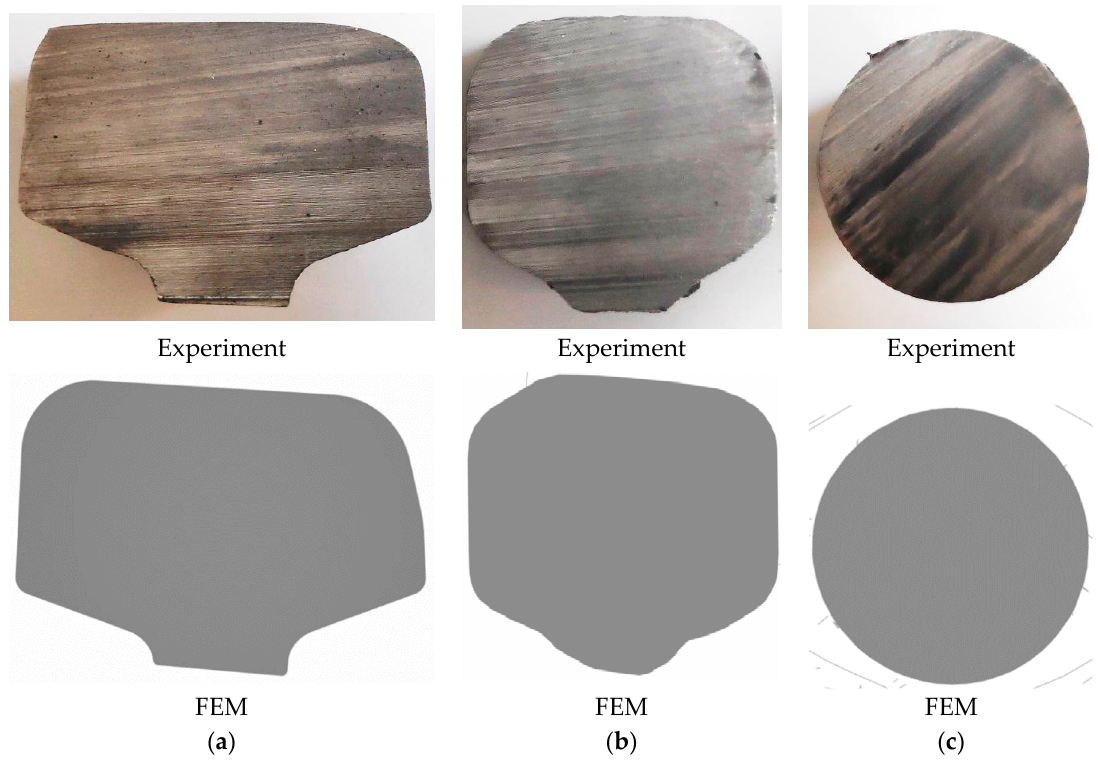
( b ) Figure 15. Changes in the shape of the workpiece during skew rolling of preforms obtained from scrap rail heads: ( a ) determined using FEM; ( b ) determined experimentally. A comparison of the cross-sections of the semifinished products obtained in the numerical simulation (Figure 15) and those rolled in the sequential stages of the rolling process (Figure 16) shows that the computational and experimental results are in a quite good accordance. Moreover,